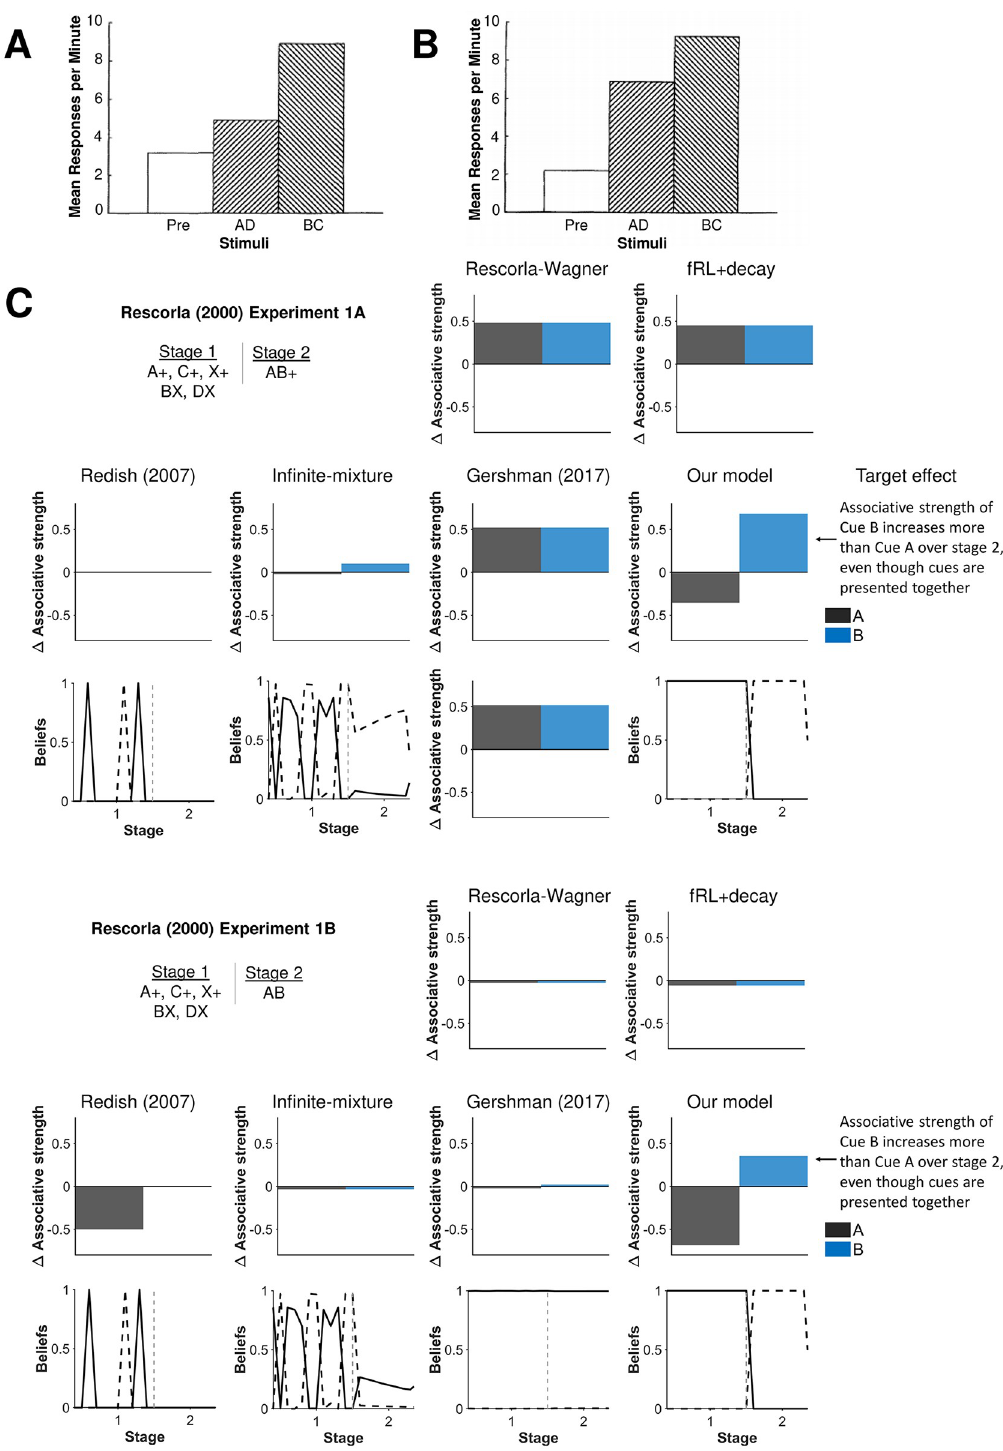
Fig 4. Another demonstration of associability depending on beliefs in latent states. Experimental results from A) Experiment 1A and B) Experiment 1B by Rescorla (2000) [39]. In both experiments, Rescorla concluded that associative strength increased more for Cue B relative to Cue A when presented together based on compound tests that showed greater responding in the compound with the Cue B than the compound with Cue A. This result suggested that associability can differ between cues even when presented together. Reprinted from “Associative Changes in Excitors and Inhibitors Differ